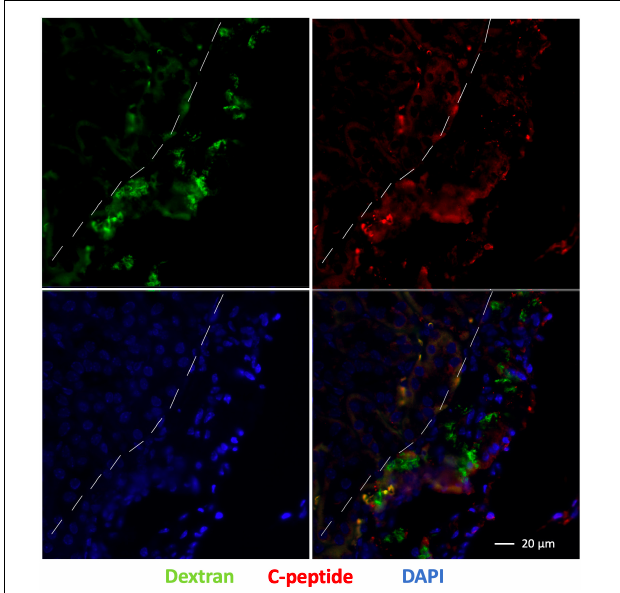
FIGURE 7 | Fluorescence immunostaining of grafts under the kidney capsule 1 week after transplantation: dextran coating (green), C-peptide (red), and cell nuclei (DAPI, blue), magnification bar = 20 µ